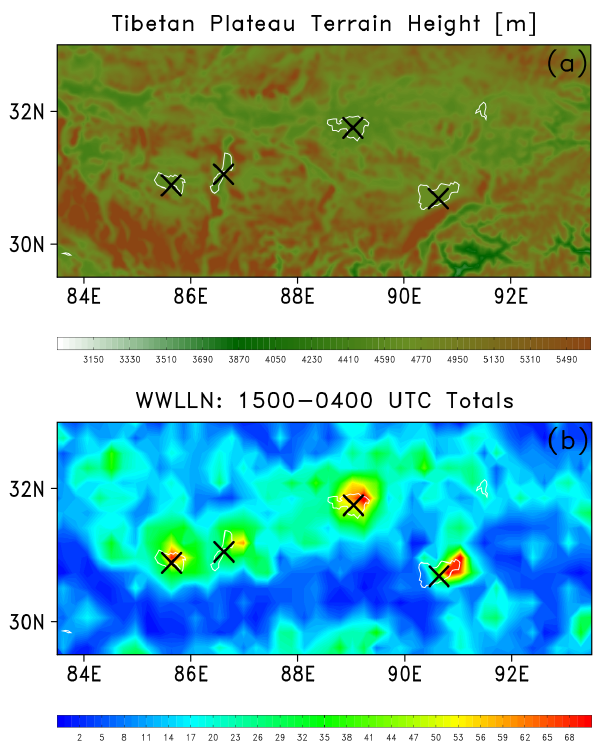
Fig. 13. (a) Terrain (m) of the Tibetan Plateau with black Xs de- noting the locations of lakes. (b) Six year (2007–2012) WWLLN lightning totals for 15:00–04:00UTC for August and September showing “hot spots” of lightning (deep convection) near the lakes (black Xs). The lightning data were binned into 25km × 25km grid